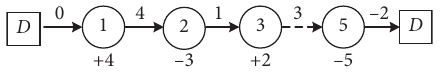
Figure 8: An infeasible solution with station 4